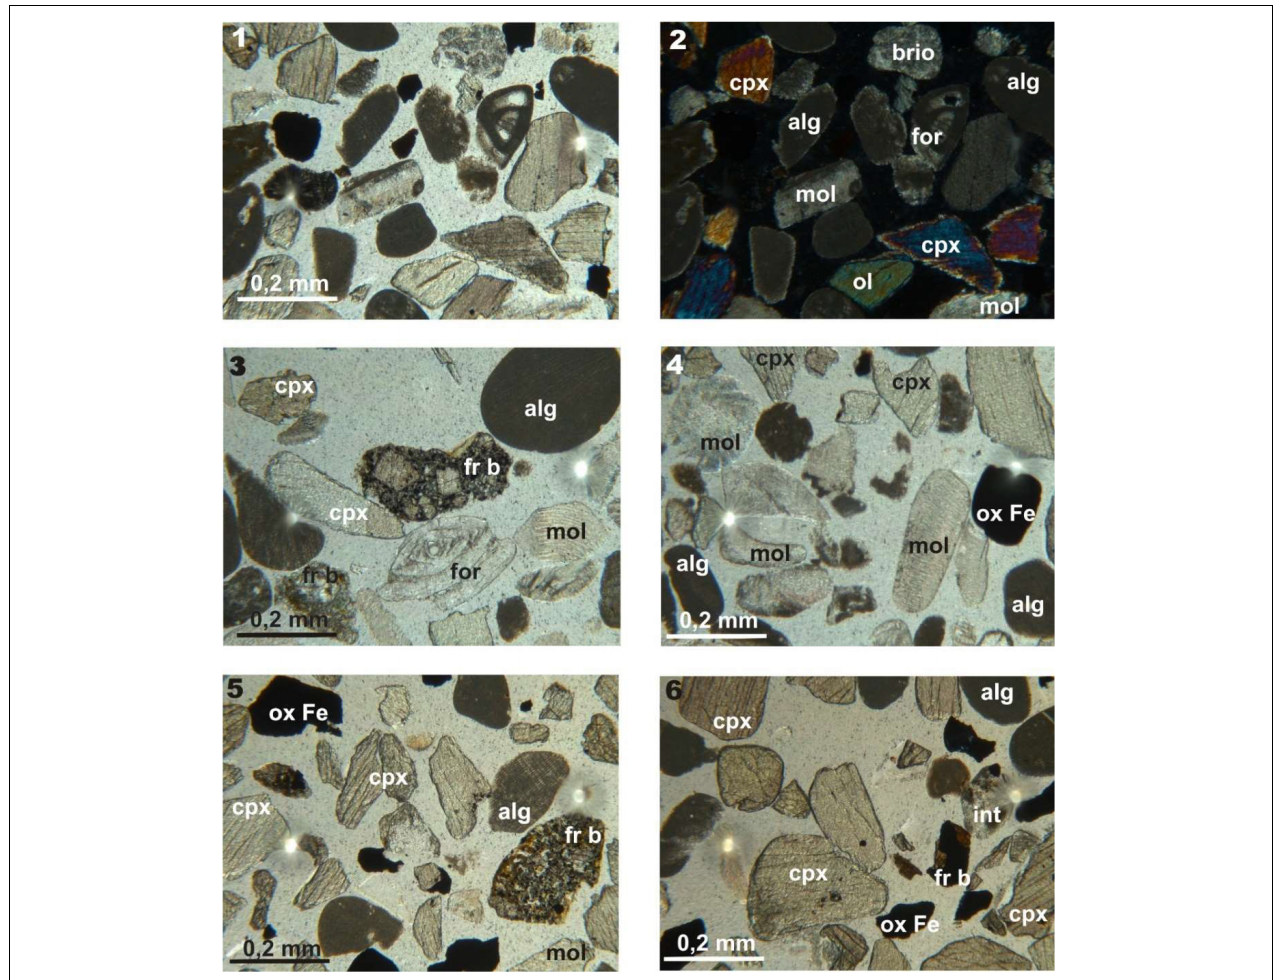
FIGURE 5 | Petrographic microscope photographs at 400 × magnification of the samples from the light ( 1 and 2 ), mixed ( 3 and 4 ), and dark ( 5 and 6 ) sands. The difference between polarised light (parallel nicols, Photo 1) and plane light (crossed nicols, Photo 2) is illustrated. Alg, meshes of red algae; mol, molluscs; brio, bryozoans; for, foraminifera; cpx, clinopyroxene; ol, olivine; Fe ox, Fe and Ti oxides; fr g, basalt rock fragment; int,